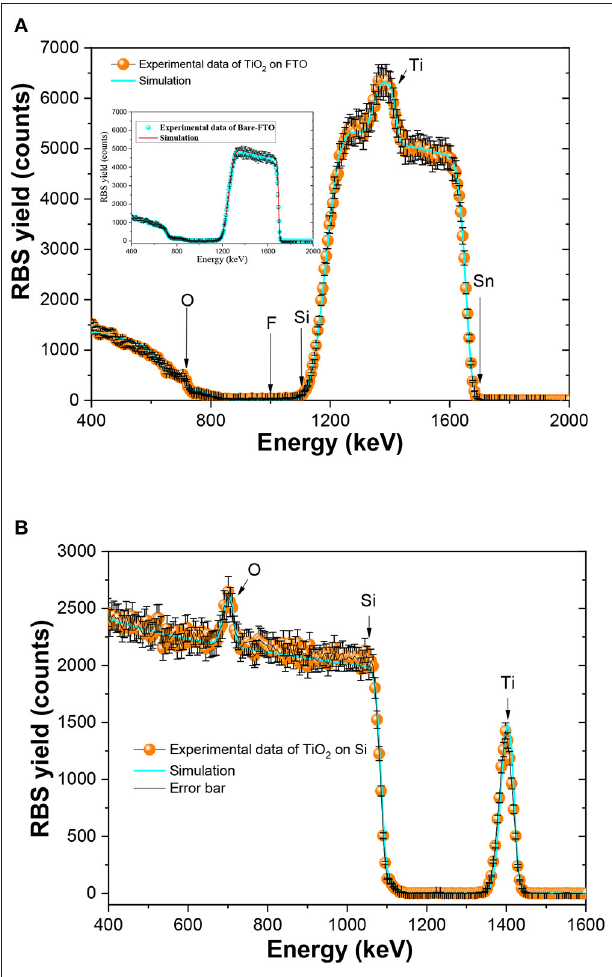
FIGURE 3 | Experimental and simulated RBS spectra and error bar for TiO 2 films deposited at 250 ◦ C on FTO (A) , and Si (B) . RBS spectrum of the bare-FTO substrate is showed inset of (A)